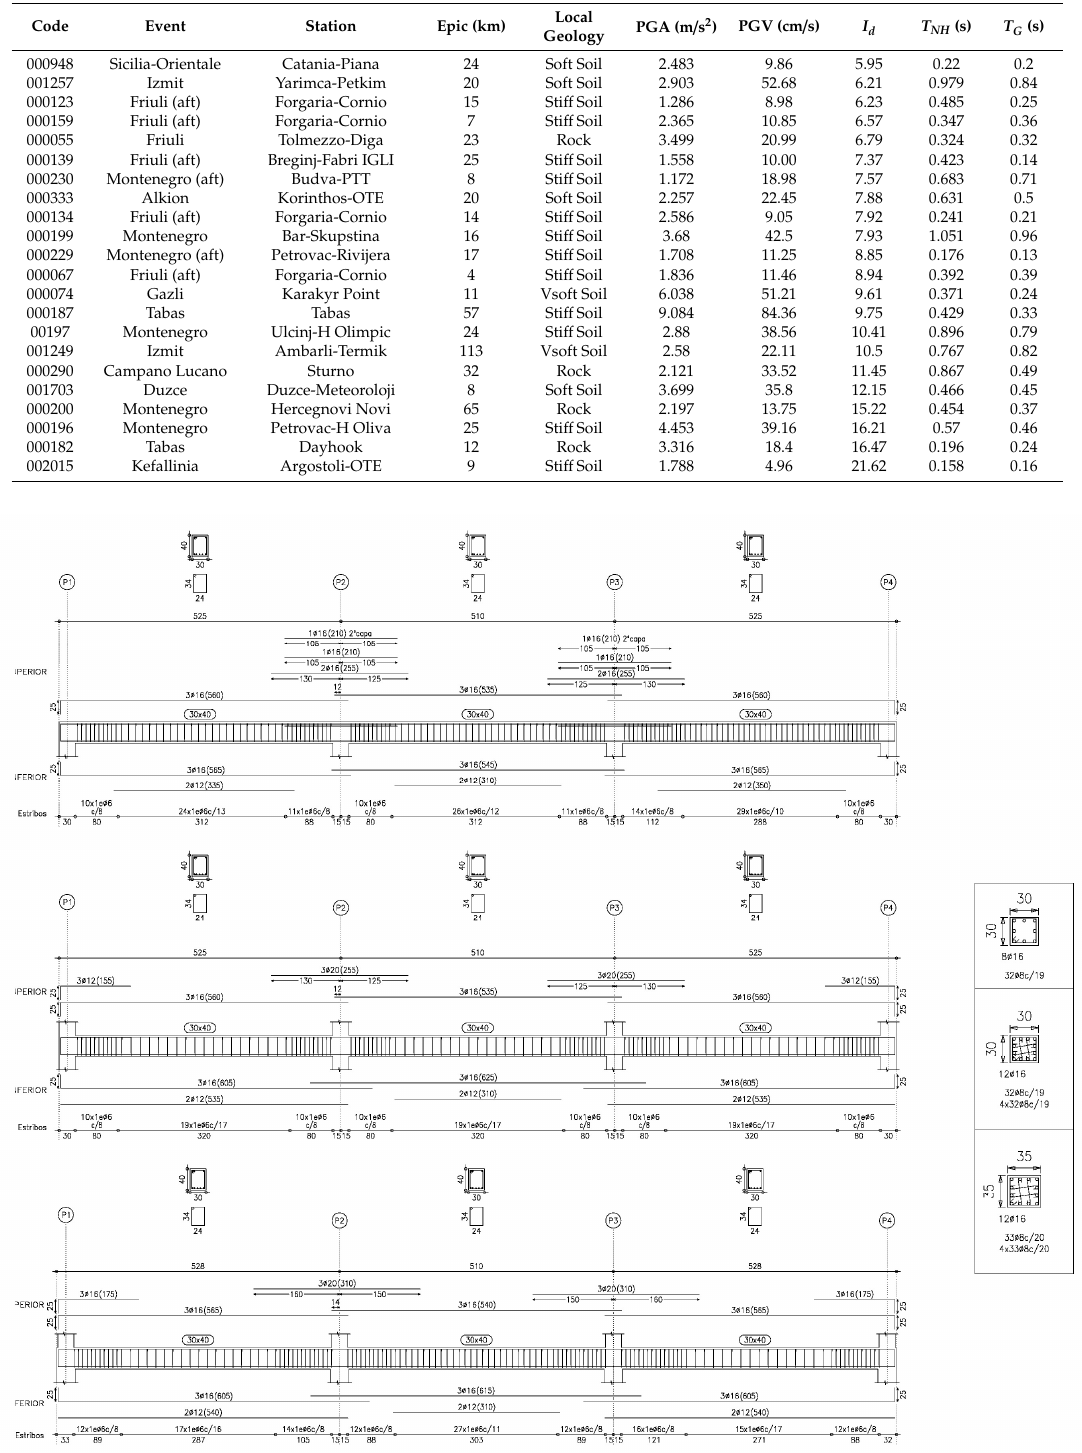
Table A2. Properties of ground motion records in the far fault set.